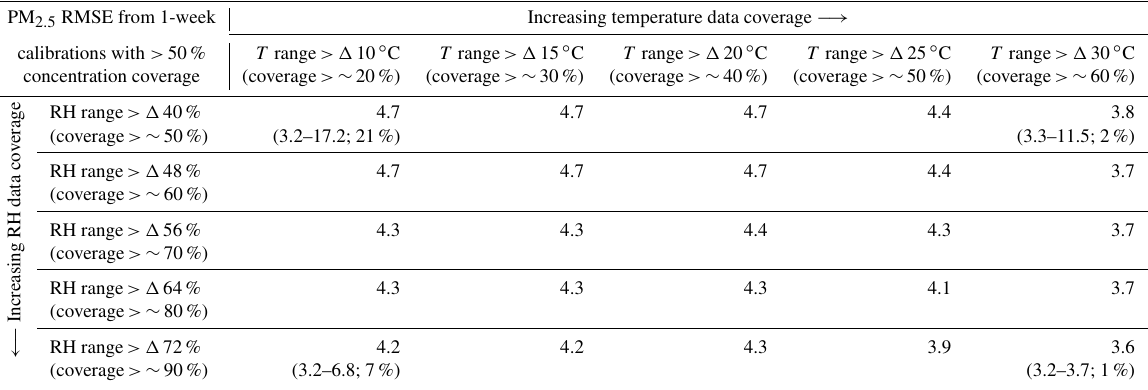
Figure 3. Example comparison of two potential 1-week calibration periods. These were selected to illustrate the range of potential RMSE values that can result from using different periods of the same co-location duration. In the example here, “Calibration Period 1” yielded more accurate concentrations (shown in green; RMSE = 3.1µgm − 3 ), whereas “Calibration Period 2” performed poorly when considered across the whole evaluation period (shown in red; RMSE = 19.5µgm − 3 ). (a) The calibrated PM 2 . 5 (µgm − 3 ) time series are shown using the two test calibration periods and the reference data (black) from February to August 2019. (b) Scatterplot of PM 2 . 5 data from the two calibration periods compared to reference data in comparison to the full data set. (c) Comparison of RH and ambient temperature for the two calibration periods compared to data from the full year. Table 3. Comparison of the median RMSE (µgm − 3 ) for PM 2 . 5 from 1-week calibration periods with different coverages of temperature and RH conditions. Only calibration periods with more than 50% coverage of the PM 2 . 5 concentration range were included in the table ( > 50% corresponds to 26µgm − 3 or more in this data set). For four scenarios (e.g., PM 2 . 5 coverage > 50%, RH coverage > 50%, T cov- erage > 20%), the 1st percentile RMSE, the 99th percentile RMSE, and the percentage of calibrations that exhibited all required conditions (e.g., RH > X% and T > X%) are shown (1st–99th percentile; %). For comparison, the median (1st–99th percentile) of the PM 2 . 5 1-week calibration periods from the full data set (i.e., no coverage requirements) was 6.6µgm − 3 (3.1–18.3µgm − 3